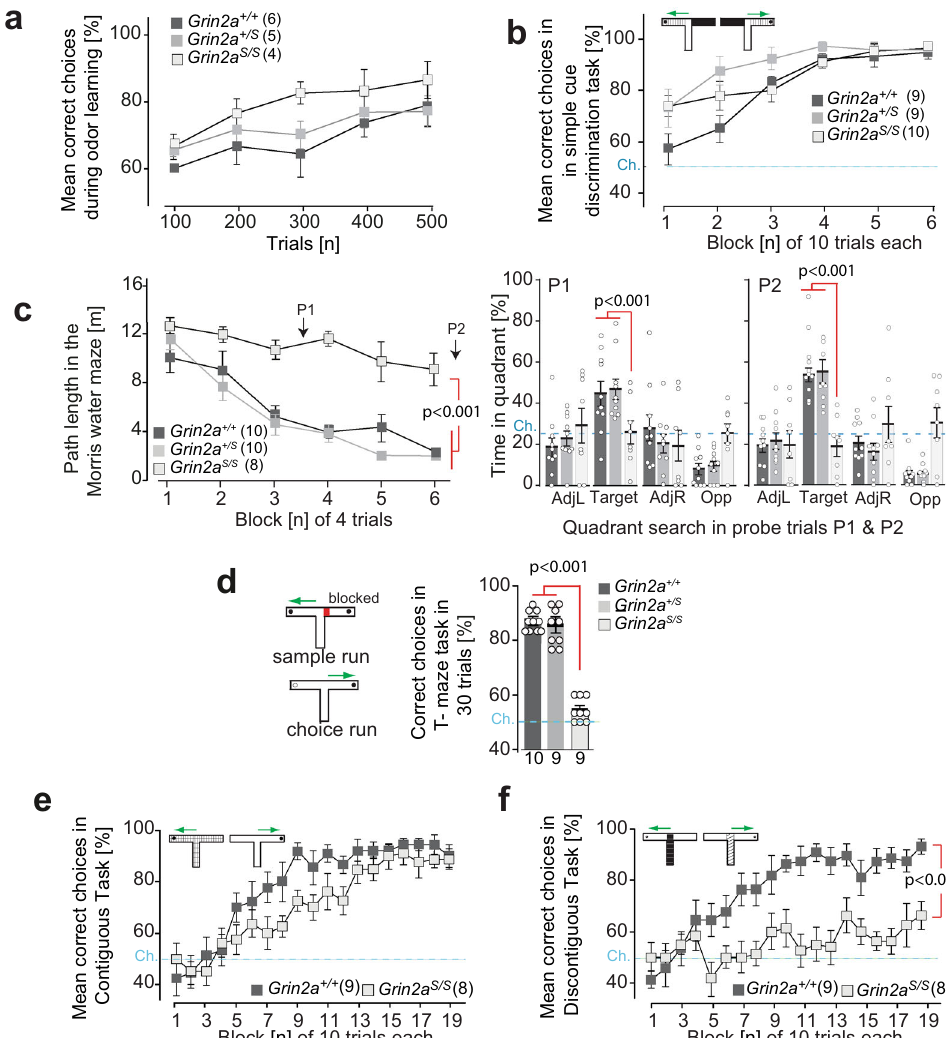
Fig. 8 Associative learning in GluN2A(N615S) expressing mice. a Odor discrimination. Grin2a S/S learned to discriminate between amyl acetate and ethyl butyrate in a rewarded go/no go-paradigm (250 trials for each odor stimulus, pseudo-randomized, and counterbalanced by stimulus identity across animals). Acquisition was similar for all three genotypes. b Simple visuo-tactile discrimination. Grin2a S/S mutant mice showed normal acquisition in the simple discrimination T-maze task and were able to associate a speci fi c visuo-tactile insert (black foam versus light blue toweling) with a milk reward. c Morris watermaze. In the standard Morris watermaze task (left graph) the path length to reach the hidden platform decreased across training blocks for Grin2a + / + and Grin2a + /S mice but not for Grin2a S/S mice. Two probe trials were conducted after 12 and 24 training trials (P1 and P2, respectively) during which the platform was removed from the pool. At both P1 and P2 (right bar graphs) the Grin2a S/S mice failed to search for the platform in the target quadrant. AdjL adjacent left, Target fi xed location of the hidden escape platform during acquisition, AdjR adjacent right, Opp opposite of target quadrant. Dashed lines indicate chance levels. d Rewarded alternation. (left) In the T-maze rewarded alternation task (right) spatial working memory performance was substantially impaired in Grin2a S/S mice. e Contiguous task. In the contiguous version of the conditional T-maze task (with fl oor inserts covering the entire T-maze; white Perspex versus gray wire mesh), Grin2a + / + and Grin2a S/S mice were able to associate a particular fl oor insert with the location of the reward in either the left or the right goal arm. f Discontiguous task. Separate groups of mice were trained in the discontiguous version of this conditional task, in which the fl oor insert cues were now limited to the start arm only. Grin2a + / + mice readily acquired the task, but Grin2a S/S mice failed to learn. The numbers of mice are shown in brackets or below the bars of bar graphs. Chance levels (Ch.) are indicated by dashed lines. Error bars represent mean ± SEM (for statistics: Supplementary Statistics to Fig.